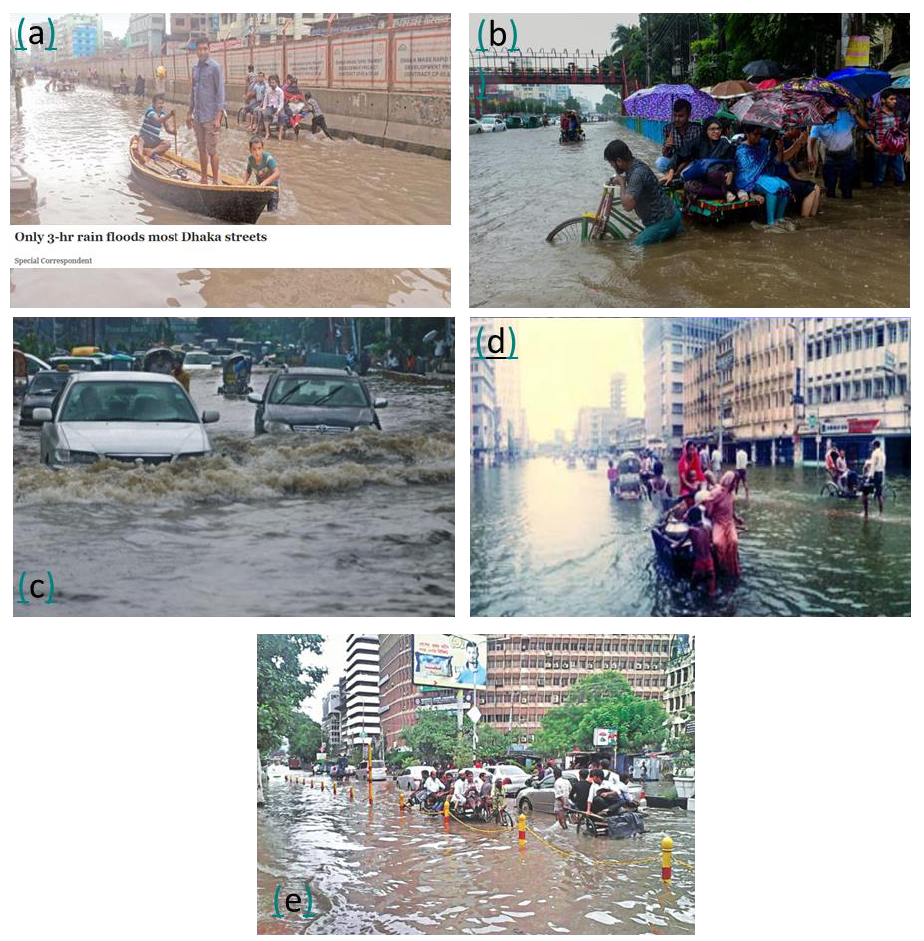
Figure 11. Ground scenario of Dhaka storm flood ( a ) The inundation occurred due to only 81 mm of rains between 6:00–9:00 a.m., 1 June 2018 [100] ; ( b ) Dhaka flood inundation, 21 March 2018 [101] ( c ) Dhaka flood, 14 September 2007 [102] ; ( d ) flooded Dhaka city [103] , and ( e ) near Sonargaon hotel, 2 September 2015 [104] .